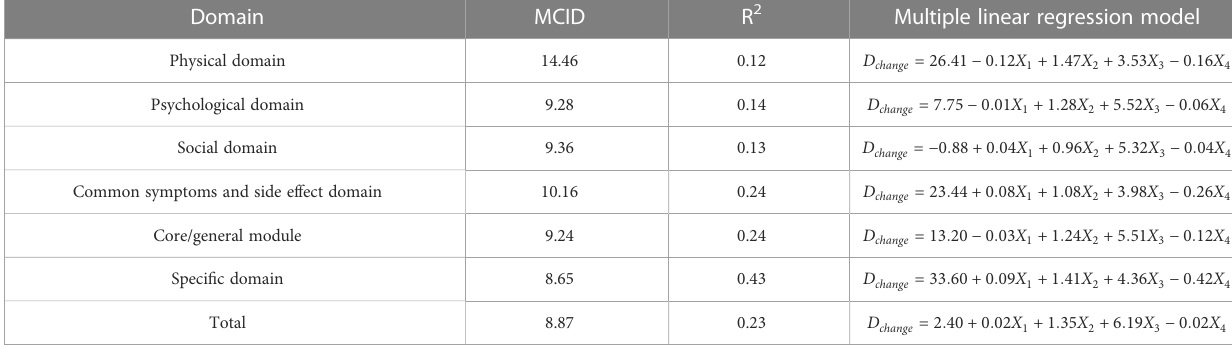
TABLE 4 The MCID of QLICP-BR (V2.0) determined by multiple linear regression models under Standard A ( n A =182). Domain